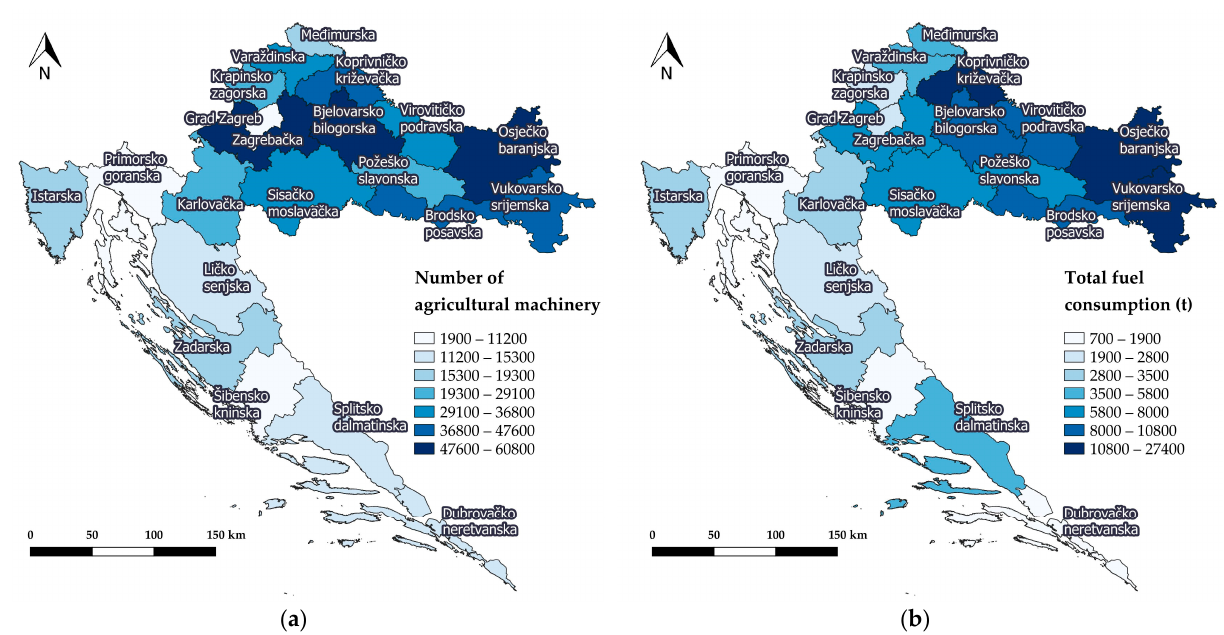
Figure 2. Spatial distribution of the number of agricultural machines ( a ) and total fuel consumption ( b ). Table 3. The number of agricultural machines and diesel and gasoline fuel consumption per county. Fuel Consumption County Number of Machines